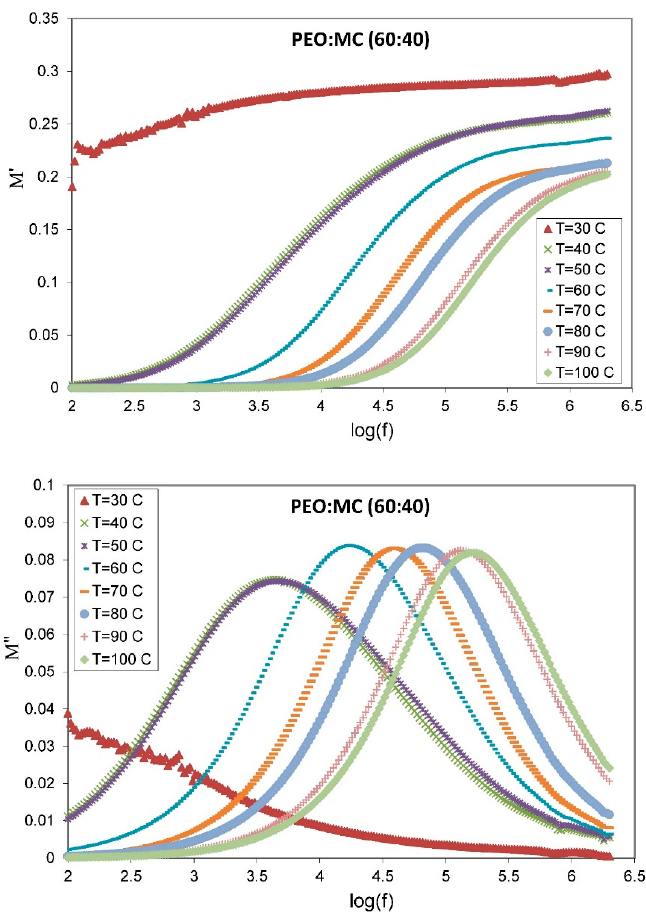
Figure 11. The frequency dependence of real M (cid:48) and imaginary parts M (cid:48)(cid:48) of the complex electrical modulus at various temperatures from 303 to 373 K for 60:40 wt.% PEO:MC.